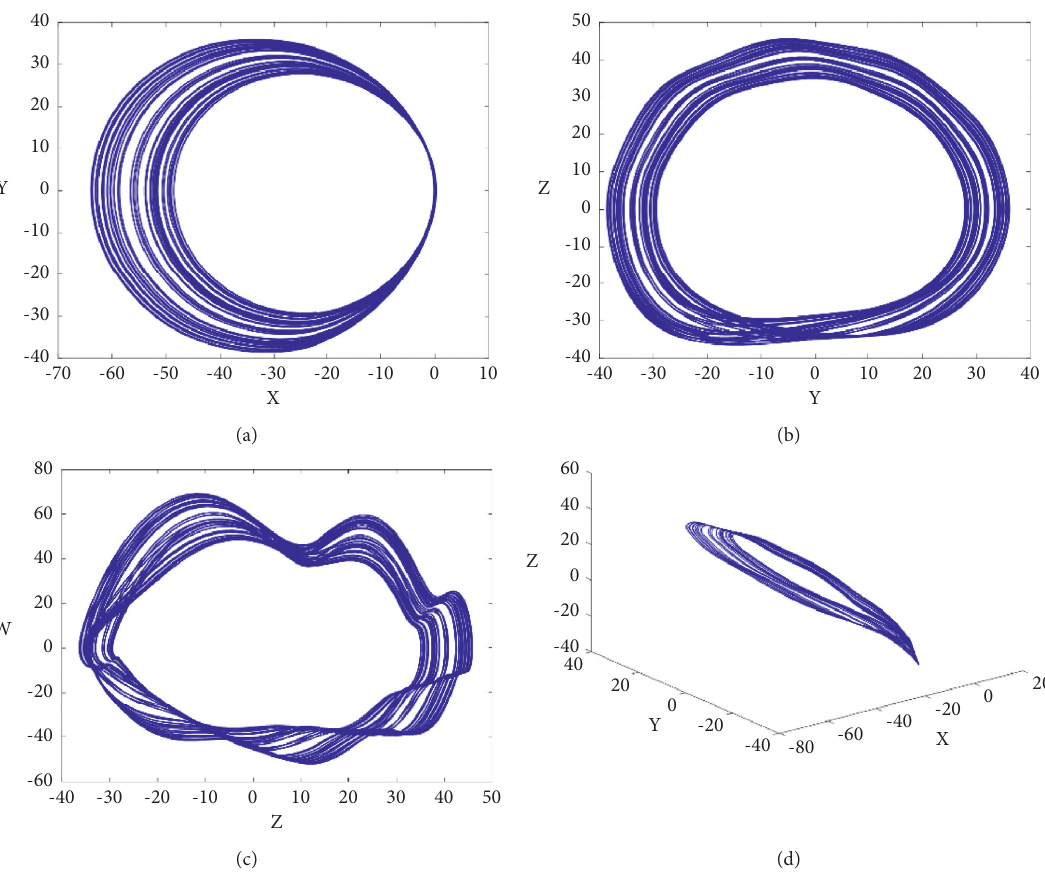
Figure 1: Attractor of system (2) and its projections in (a) xy , (b) yz , and (c) zw planes and (d) xyz space with a � 3 . 5 and b � 1 and the initial conditions are ( x